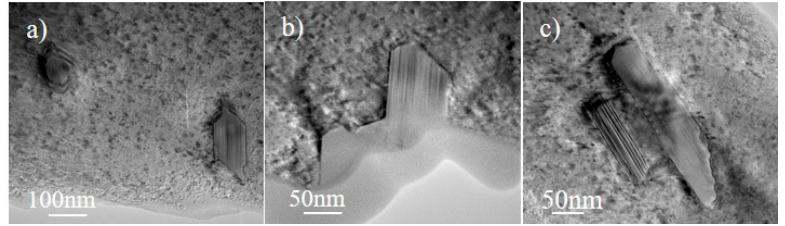
Materials 2017, 10, 1240 precipitate morphologies could be identified: (i) non-striped whisker [23], (ii) non-striped polygonal shape, (iii) striped whisker and (iv) striped polygonal shape. Figure 6. TEM image and compositional mapping of TiB and TiC formations of TMCs produced at Figure 6. TEM image and compositional mapping of TiB and TiC formations of TMCs produced at 1000 °C for 15 min. 1000 °C for 15 min. 1000 ◦ C for 15 min.